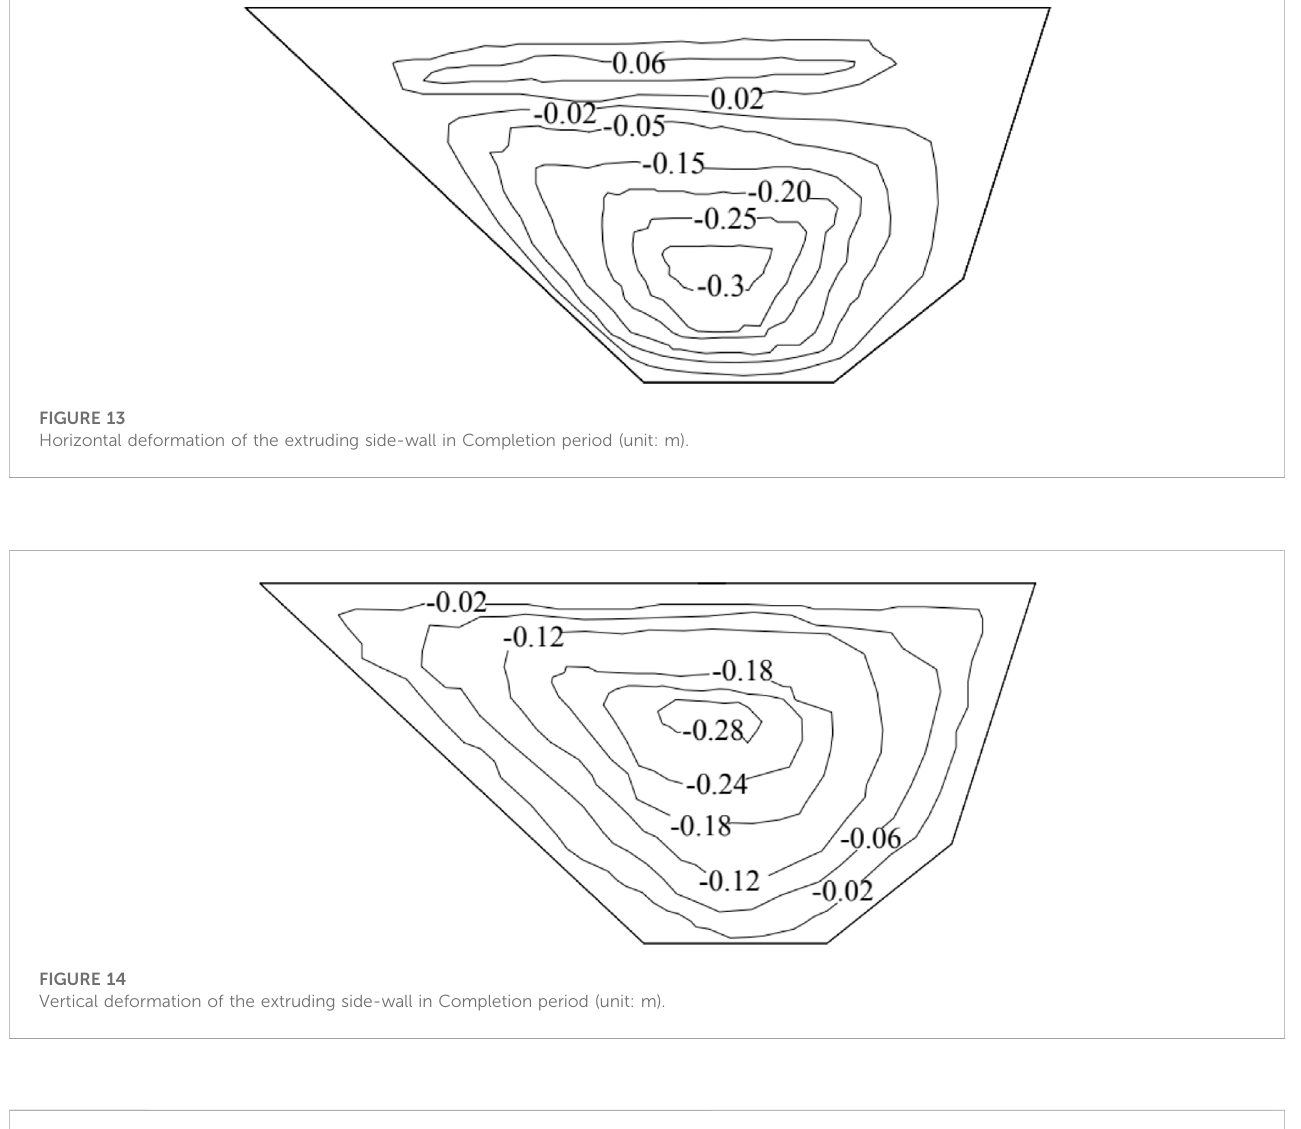
FIGURE 15 Plan Ⅰ of optimize the fi lling